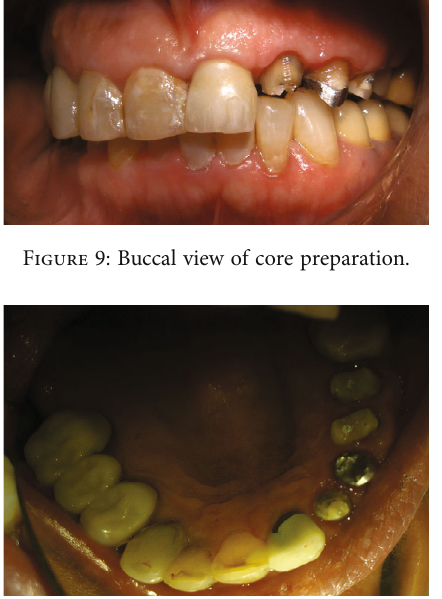
Figure 10: Occlusal view of core preparation.